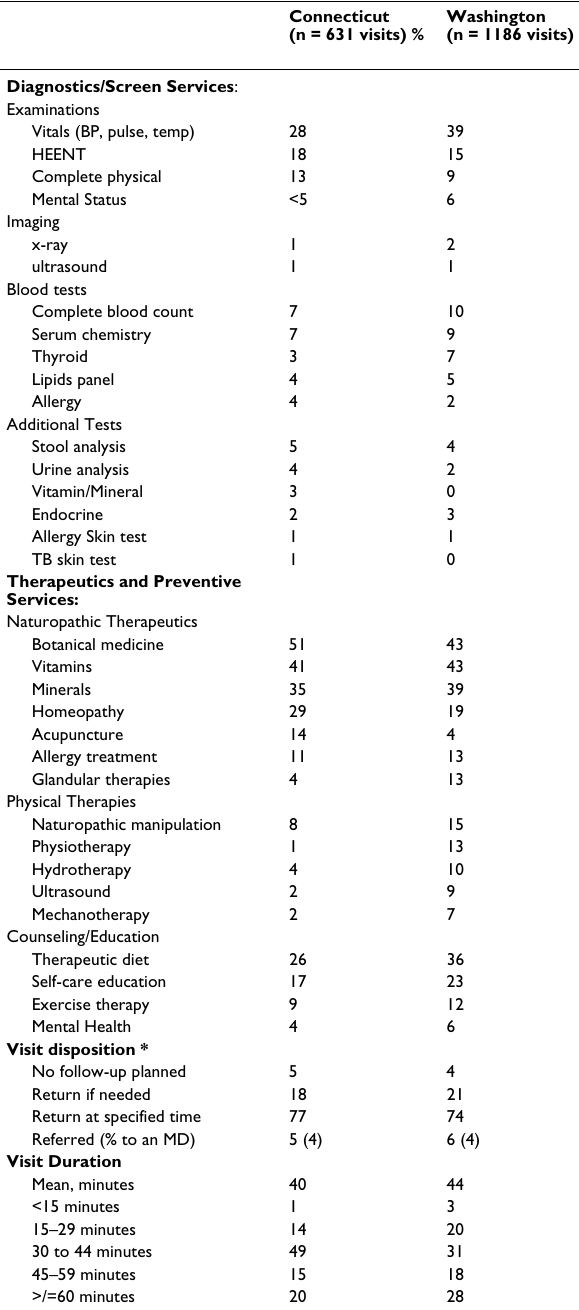
Table 5: Characteristics of visits to naturopathic physicians in Connecticut (1998) and Washington (1999)